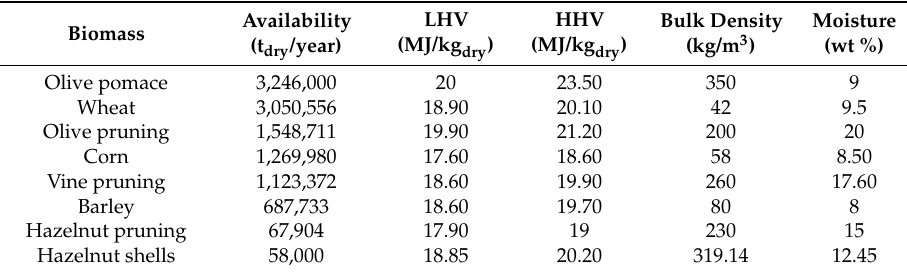
Table 2. Biomass waste most available on Italian soil.